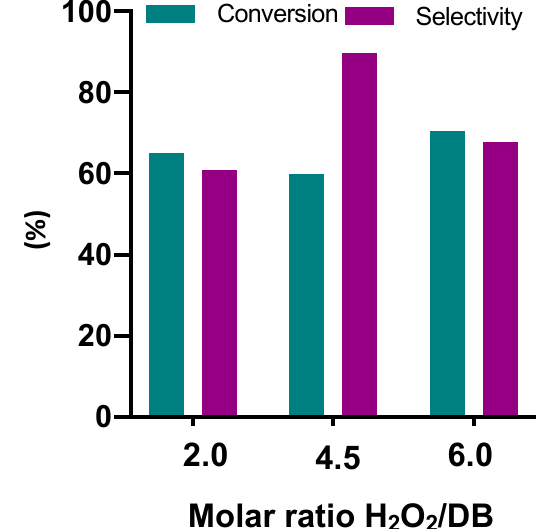
Figure 5. Conversion of double bonds (DB) and selectivity for epoxide, epoxidation, and different molar ratios of reactants. Experimental conditions: 600 mg of catalyst, 5 g (0.024 mol of double bonds) of cardoon oil, 20 cm 3 of solvent, and reaction temperature of 78–80 °C.